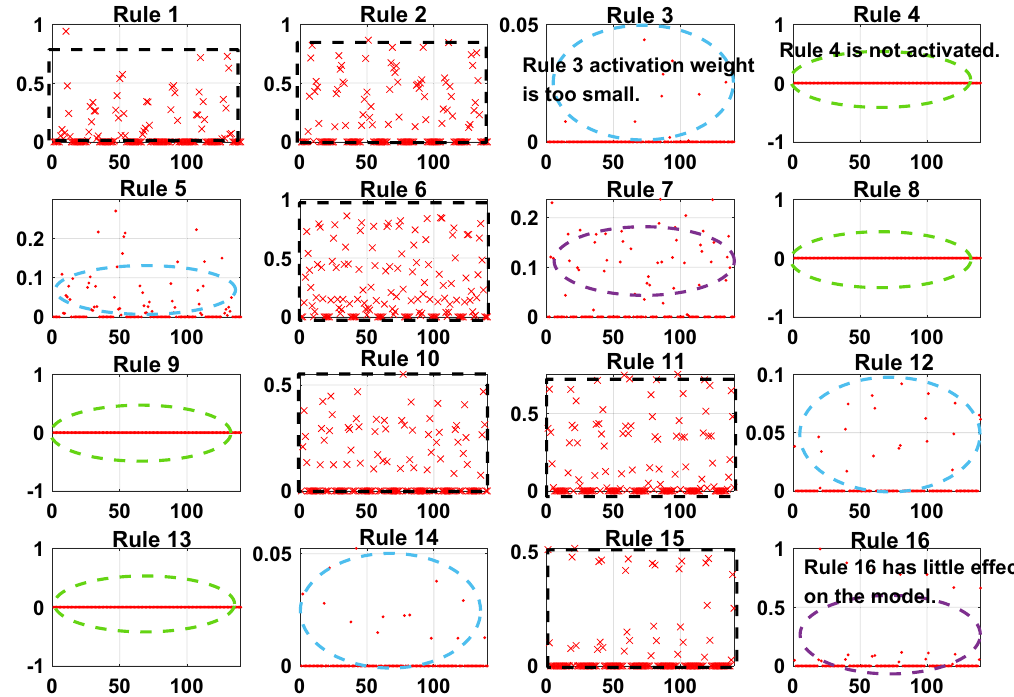
Figure 12. Analysis of Sub-BRB1 rule activation weights (x-axis represents test data, y-axis represents activation weights).